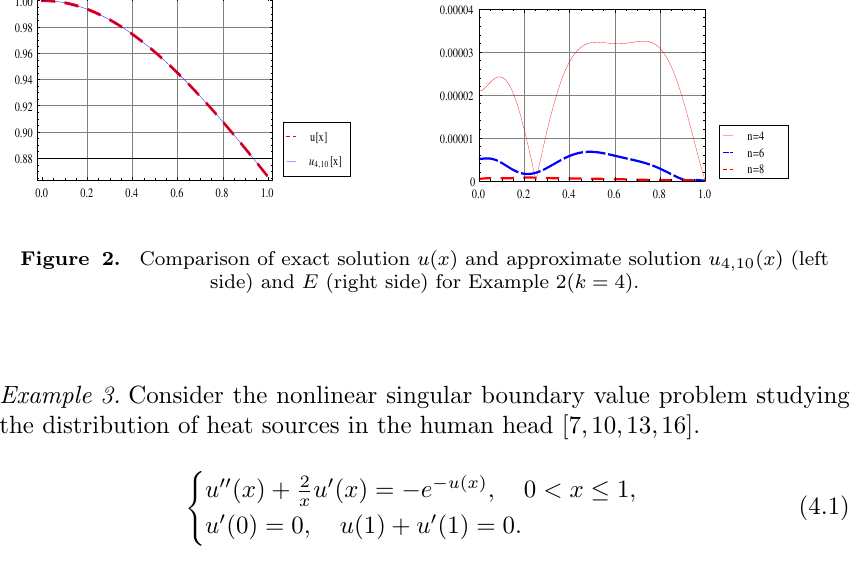
Example 3. Consider the nonlinear singular boundary value problem studying the distribution of heat sources in the human head